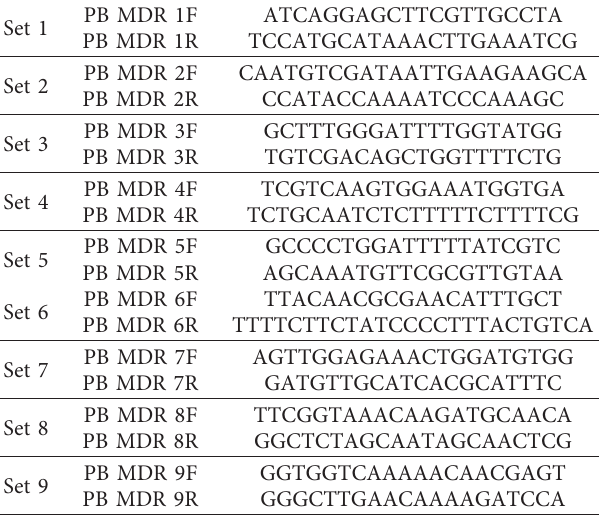
Table 2: Pb MDR1 sequencing primers.